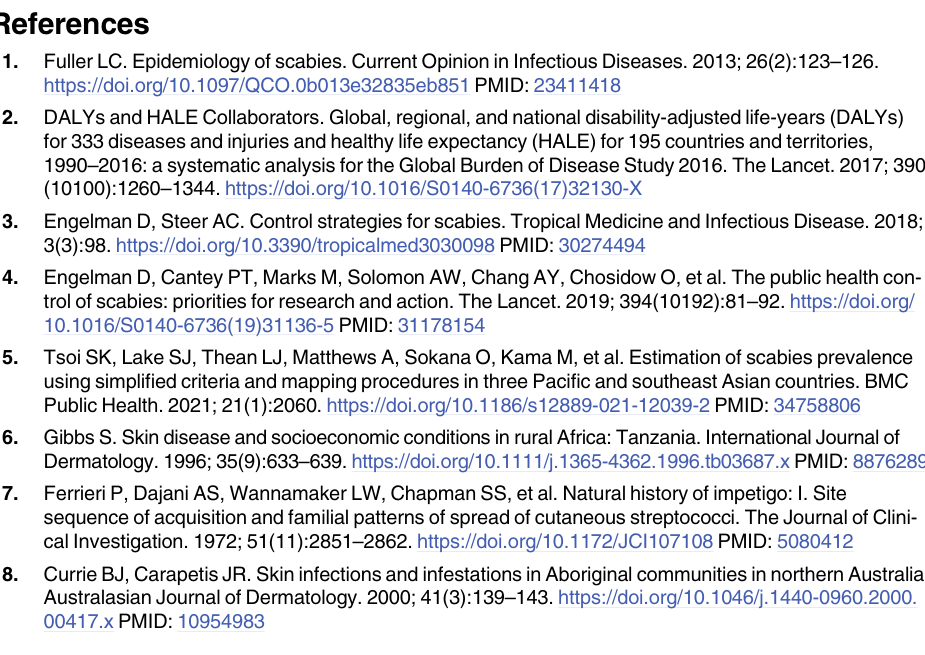
S5 Table. Required sample sizes estimated from simulation results for the simple random, household, and school sampling methods to achieve a given precision, where input scabies prevalence is distributed according to the age-and-household-specific method. Small, medium, and large population sizes represent ranges of [500, 1500], (1500, 2500], (2500, 4000]. For the scenarios with X’s in school sampling, sampling all school-aged children was insuffi- cient to have 95% confidence that prevalence within the selected precision could be obtained.